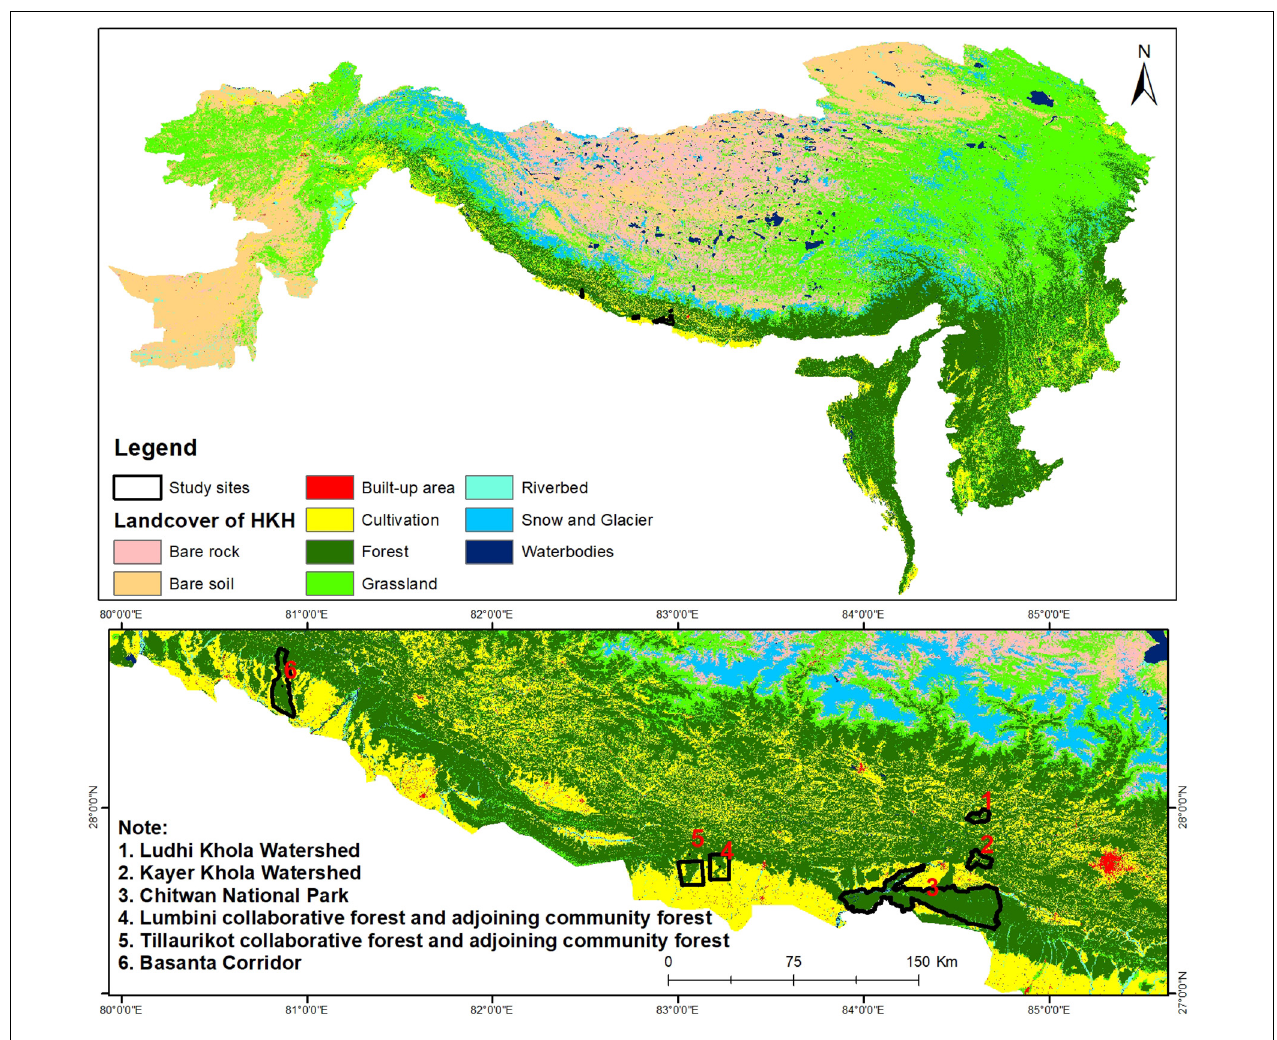
FIGURE 1 | Map of the study